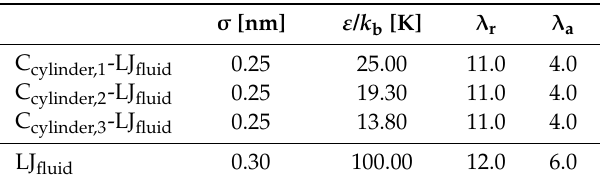
Table 1. Summary of the molecular parameters for the solid–fluid and fluid–fluid potentials. k b is the Boltzmann